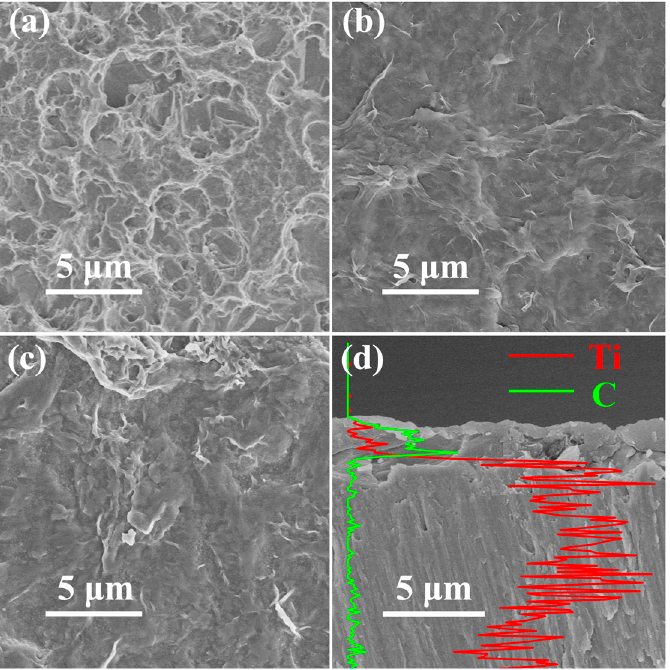
Figure 2. Surface SEM images of ( a ) Ti-Pretreated; ( b ) MGO@Ti; ( c ) RMGO@Ti; and ( d ) the cross- sectional SEM image of RMGO@Ti, with Ti (red) and C (green) profiles via EDS line scan.